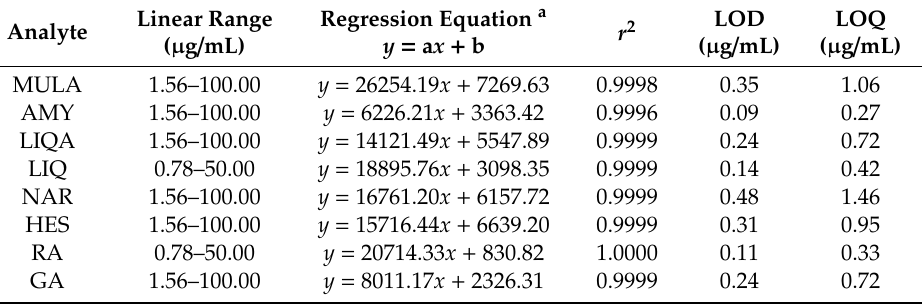
Table 1. Linear range, regression equation, r 2 , LODs, and LOQs for the eight analytes ( n = 3). Linear Range Analyte